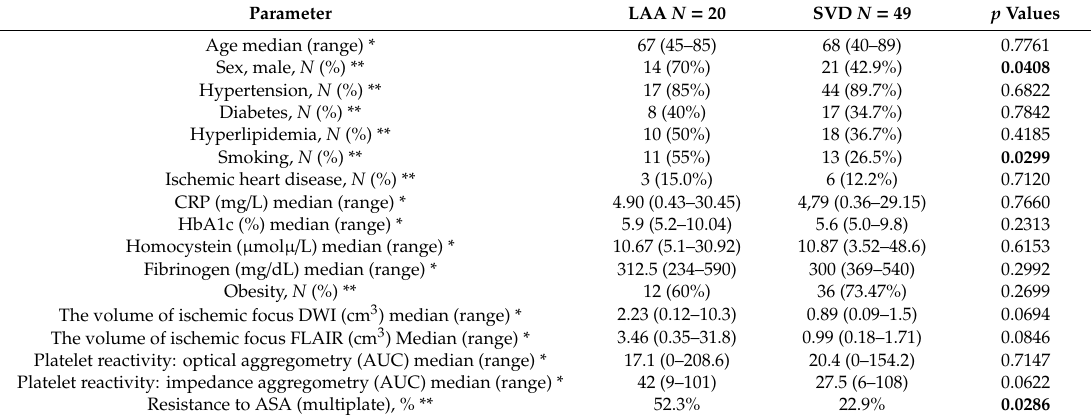
Table 1. Comparison of the selected risk factors and biochemical parameters obtained in subjects with stroke in both etiological subgroups of cerebral